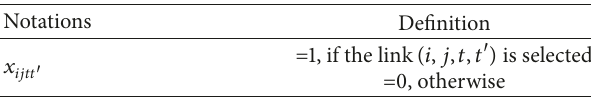
Table 3: Decision variables used in